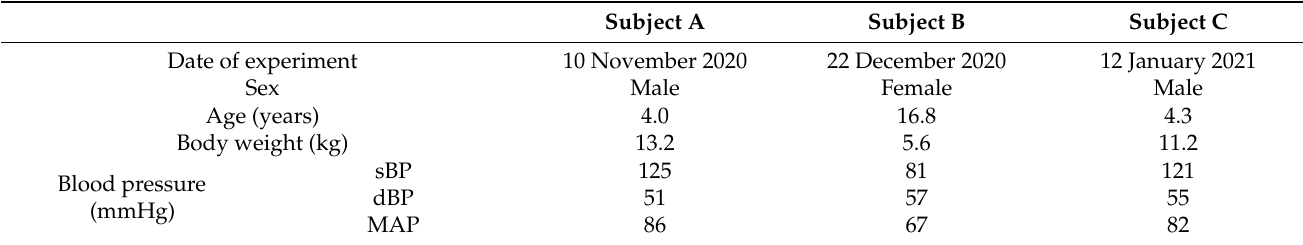
Table 1. Basic information on the 3 beagle dogs (A, B, C).